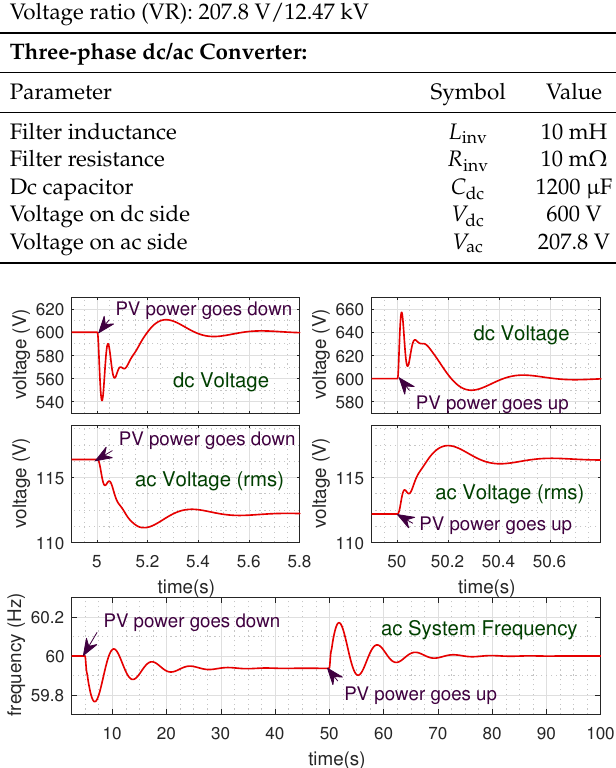
Figure 3. Voltage and frequency fluctuations at point of common coupling (PCC) of the study system due to the abrupt PV